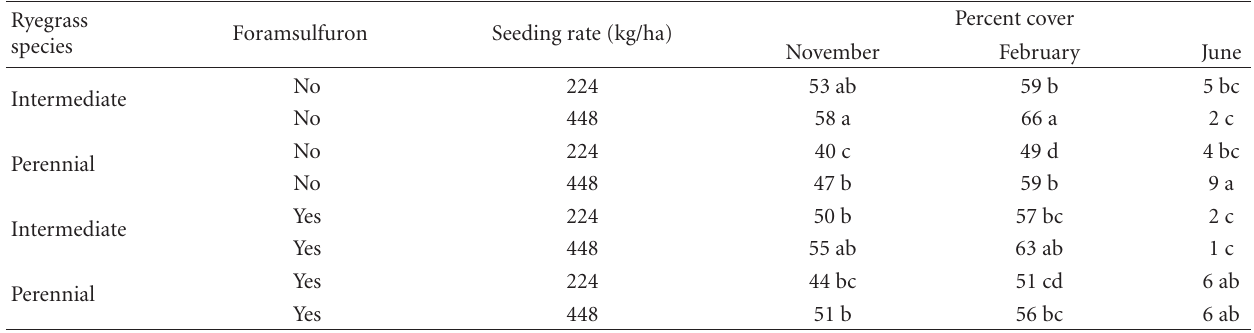
Table 2: Percent cover of ryegrasses as a ff ected by seeding rate, foramsulfuron application, and overseeded species in 2005 for the first experiment.